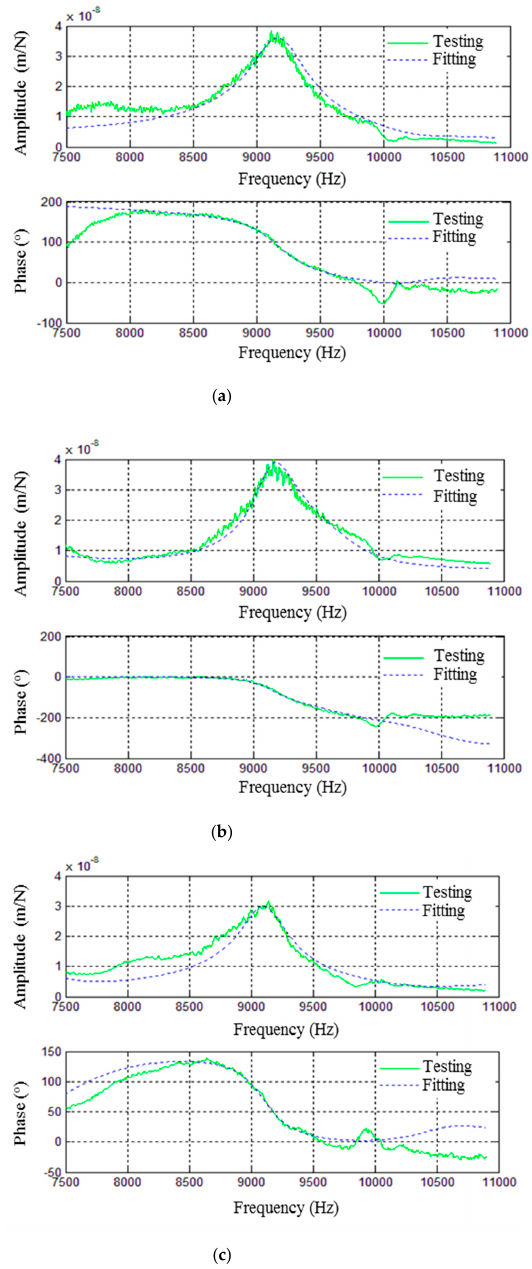
Figure 7. Frequency response function (FRF) and phase response function of the main structure in ( a ) X- direction ( b ). Y-direction ( c ). Z-direction